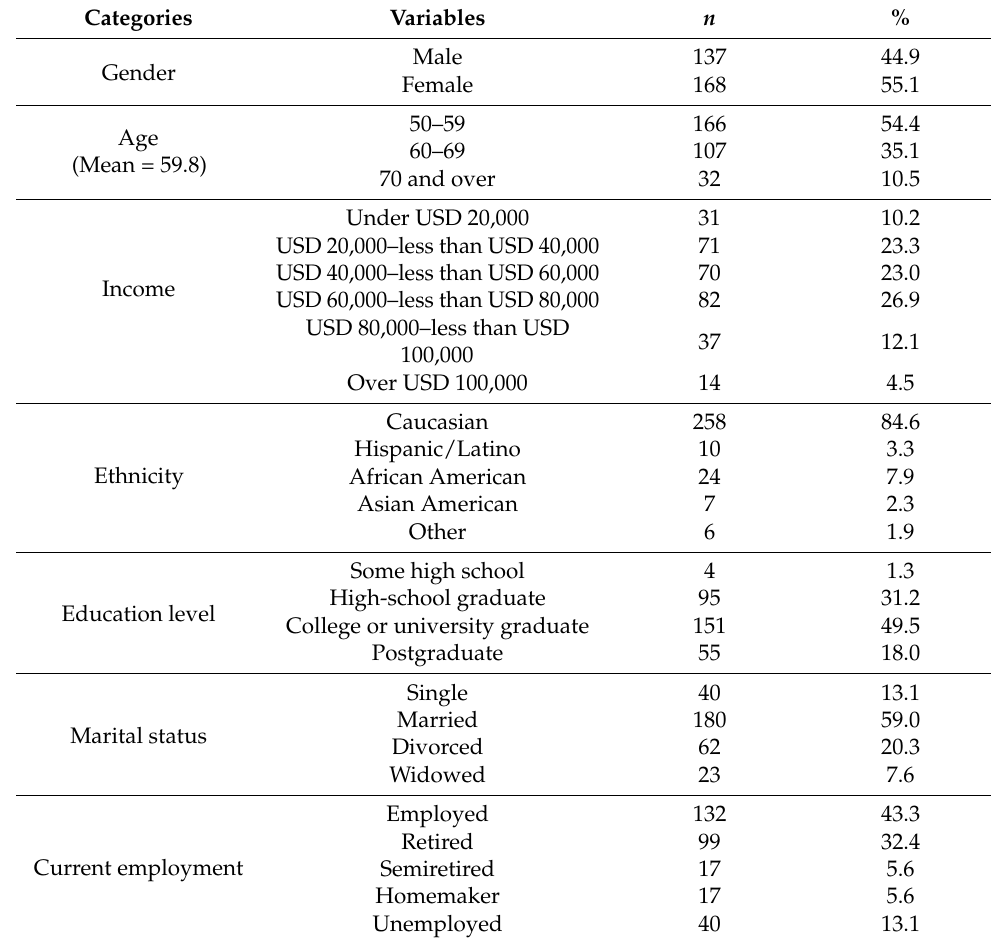
Table 1. Profile of respondents ( n = 305)